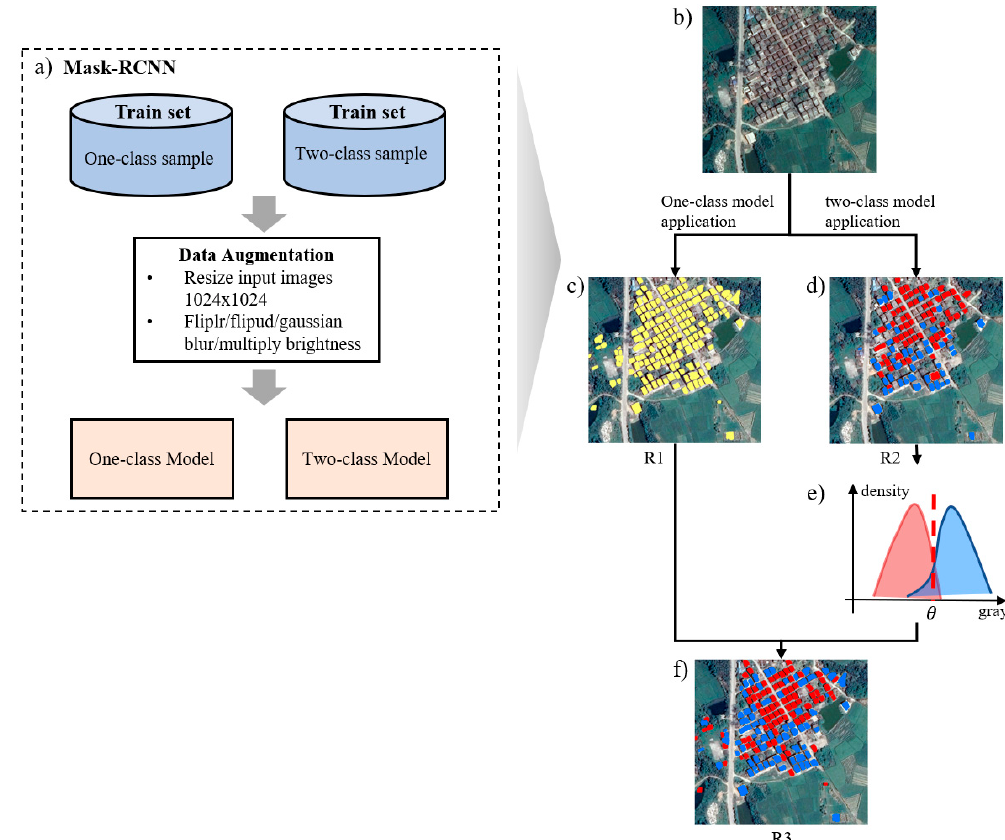
Figure 3. The workflow of HTMask R-CNN (Histogram Thresholding Mask R-CNN). ( a ) the training process of two segmentation models based on the one-class and two-class samples’ training sets; ( b ) a sample village image in the validation and test set; ( c ) R1: the prediction result of the one-class model; ( d ) R2: the prediction result of the two-class model; ( e ) the calculation of the threshold from the grayscale histogram; ( f ) R3: the prediction result of HTMask